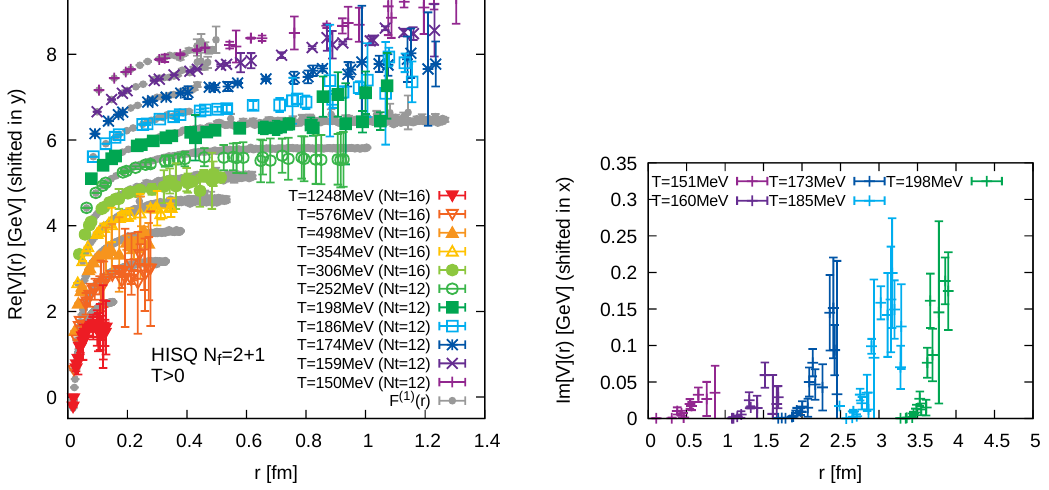
Figure 1. ( left ) Re [ V ] obtained from Pade reconstructed spectral functions of the Wilson line correlator in Coulomb gauge on 48 3 × 12,16 lattices with N f = 2 + 1 light quarks. The values are shifted by hand in y-direction for better readability from lowest temperature T = 151 MeV on top to highest T = 1451 MeV bottom. The gray data points denote the color singlet free energy in Coulomb gauge on the same lattices. ( right ) Tentative values of Im [ V ] at a selection of temperatures extracted via Bayesian inference from the same lattice